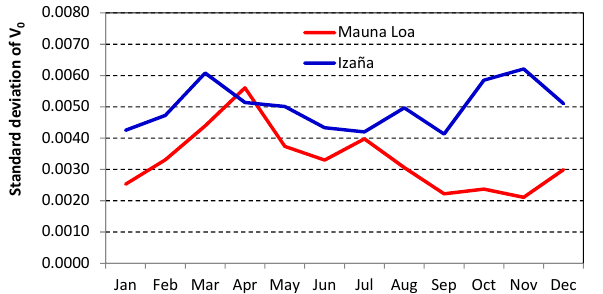
Figure 8. Standard deviation of V 0 ’s (500nm wavelength) from Langley calibrations for every month at Izaña and Mauna Loa using AERONET